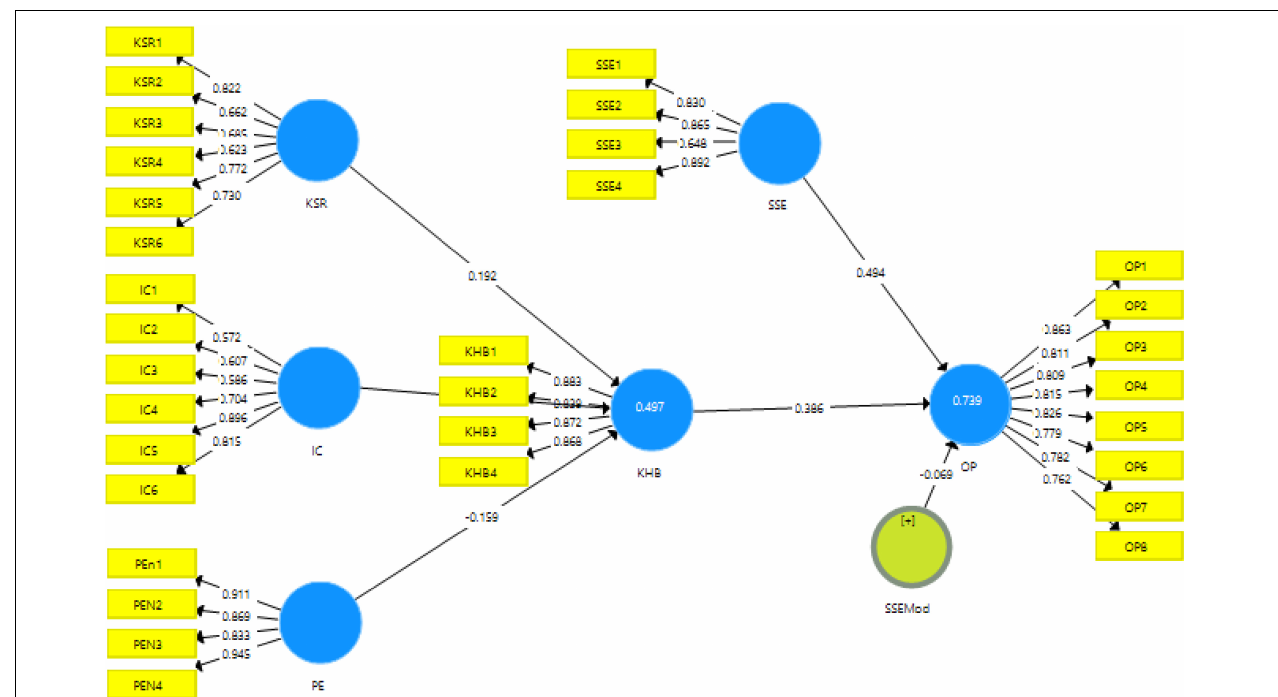
FIGURE 2 | Measurement model